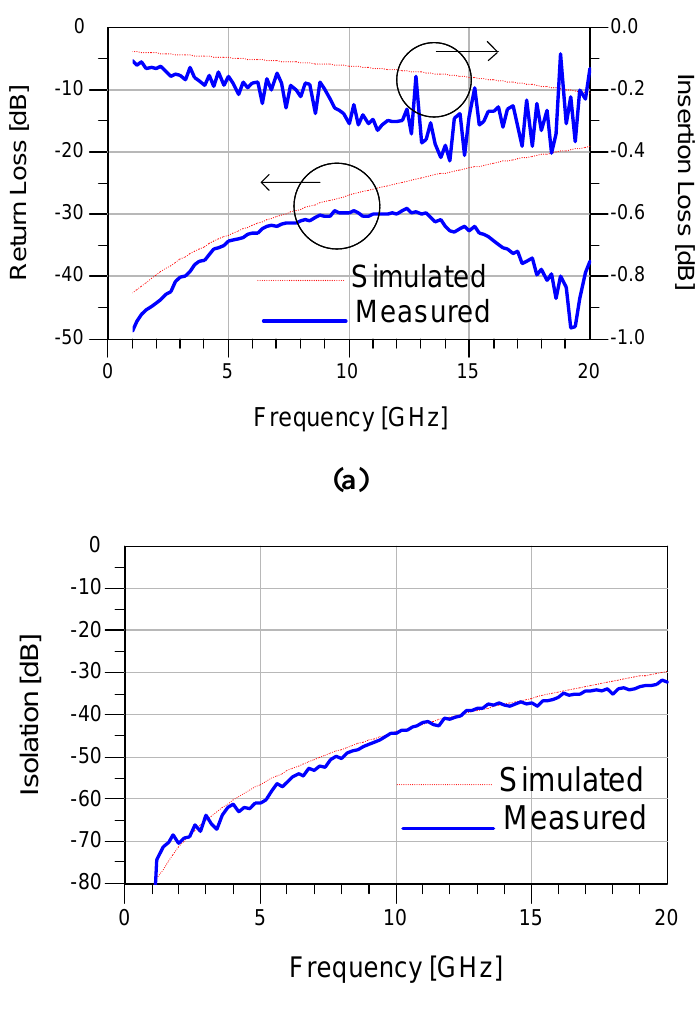
Figure 7. Measured and modeled S-parameters for the series-shunt switch, (a) On state; (b) Off